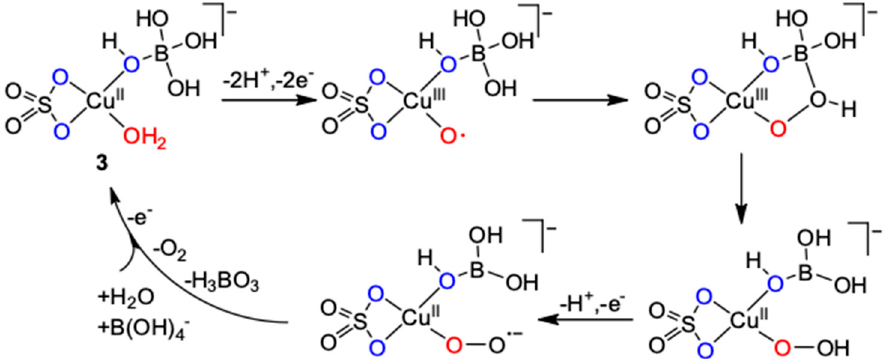
Figure 4. Proposed mechanism for the electrocatalytic oxygen evolving reaction by the ternary complex 3 [26].